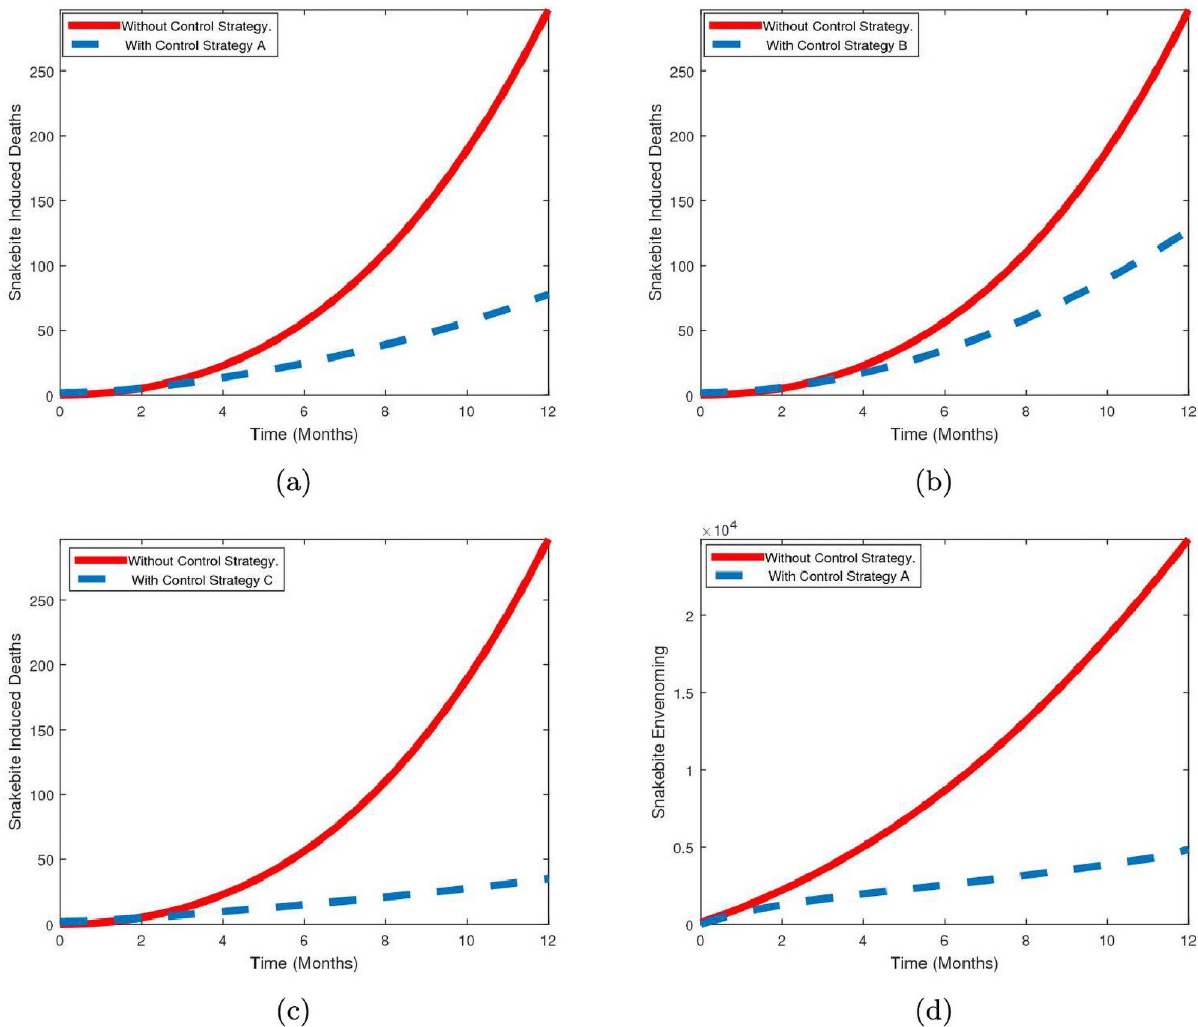
Fig 5. Simulation results of the optimal control model. The simulation results of the optimal control model showing the effectiveness of (a) strategy A in averting the number of snakebite induced deaths as against without strategy, (b) strategy B in averting the number of snakebite induced deaths as against without strategy, (c) strategy C in averting the number of snakebite induced deaths as against without strategy, (d) strategy A in averting number of snakebite envenoming as against without strategy. In the graphs the solid line denotes without strategy while dotted line indicates with control